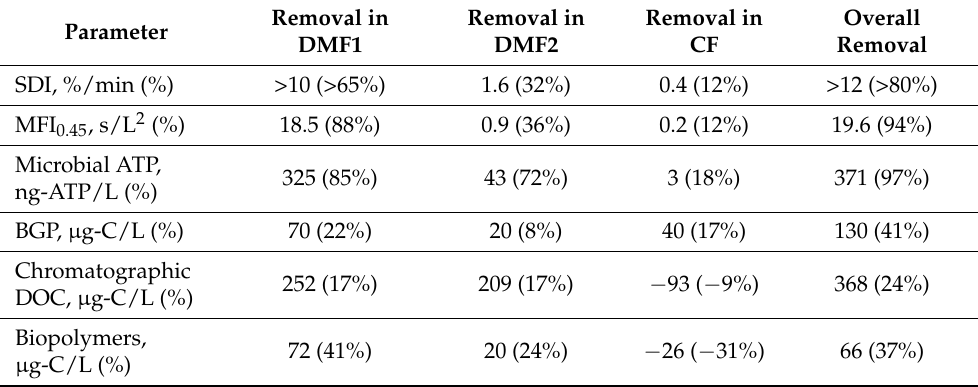
Table 4. Summary of removal of different fouling parameters in SWRO